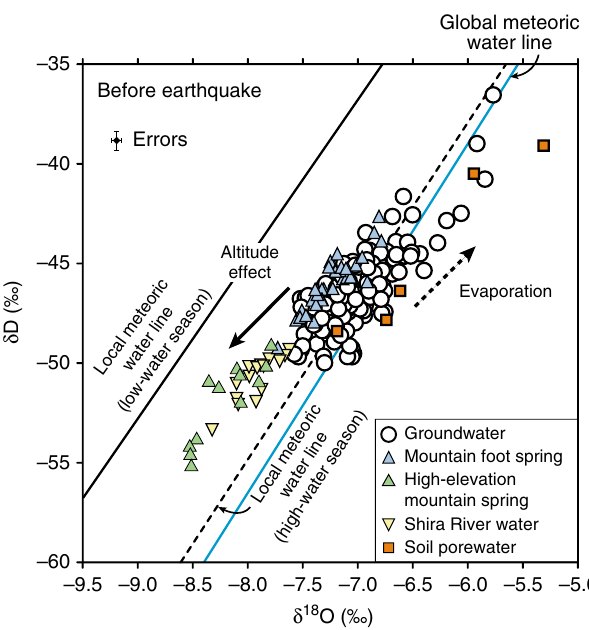
Fig. 2 Isotopic compositions of waters before the earthquake. Oxygen and hydrogen stable isotope ratios characterizing the original hydrological systems in Kumamoto. Samples from different seasons are included. Two local meteoric water lines including high-water (during April to September, n = 70) and low-water (during October to March, n = 65) seasons are shown in the fi gures using monthly precipitation data (see Methods). The global meteoric water line and isotopic evolution trends due to altitude effects and evaporation are from refs. 55 – 57 . Error bars in the fi gure represent analytical